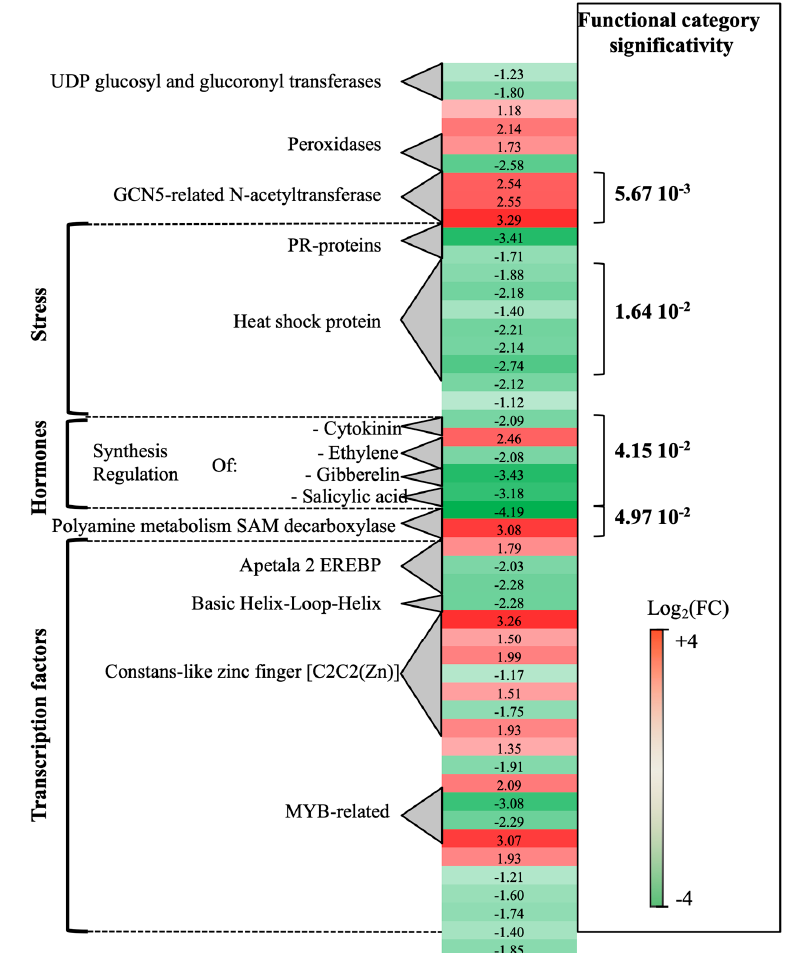
Figure 1. Global aspects of the grapevine transcriptome evolution from 0- to 14-dpi according to the treatments. Major functional categories obtained after Limma analysis and Mapman classification for root-inoculated grapevine with Pythium oligandrum , in the absence of pathogen infection. The red color means overexpression at 14-dpi and the green color means overexpression at 0-dpi.